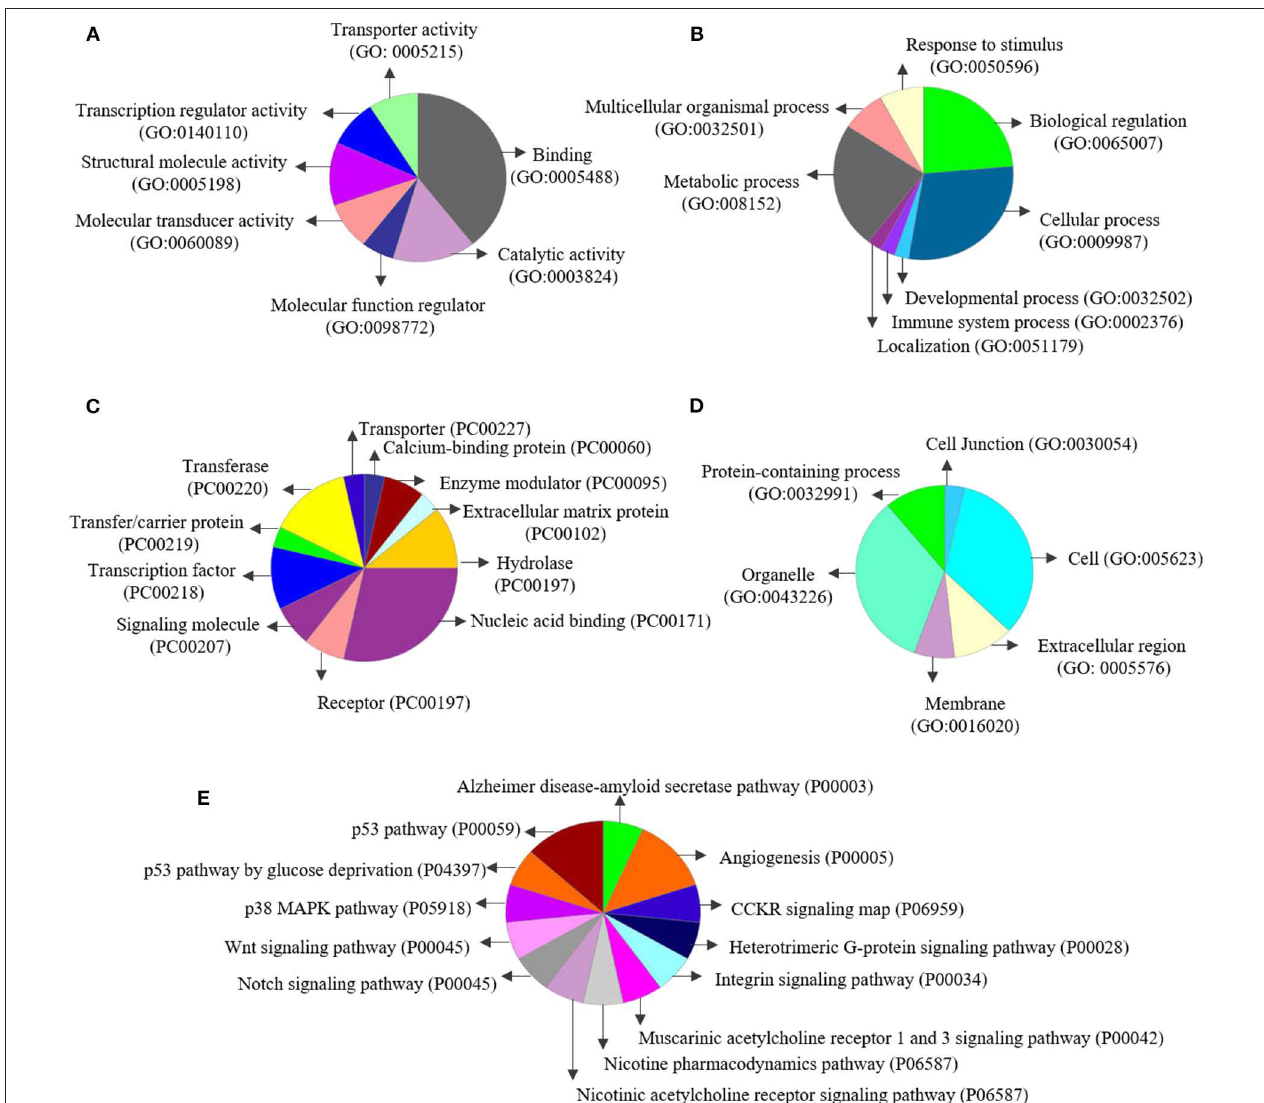
FIGURE 8 | Enrichment analysis performed using Panther (http://pantherdb.org/): Enrichment for (A) molecular functions, (B) biological processes, (C) protein classes, (D) cell components, and (E)